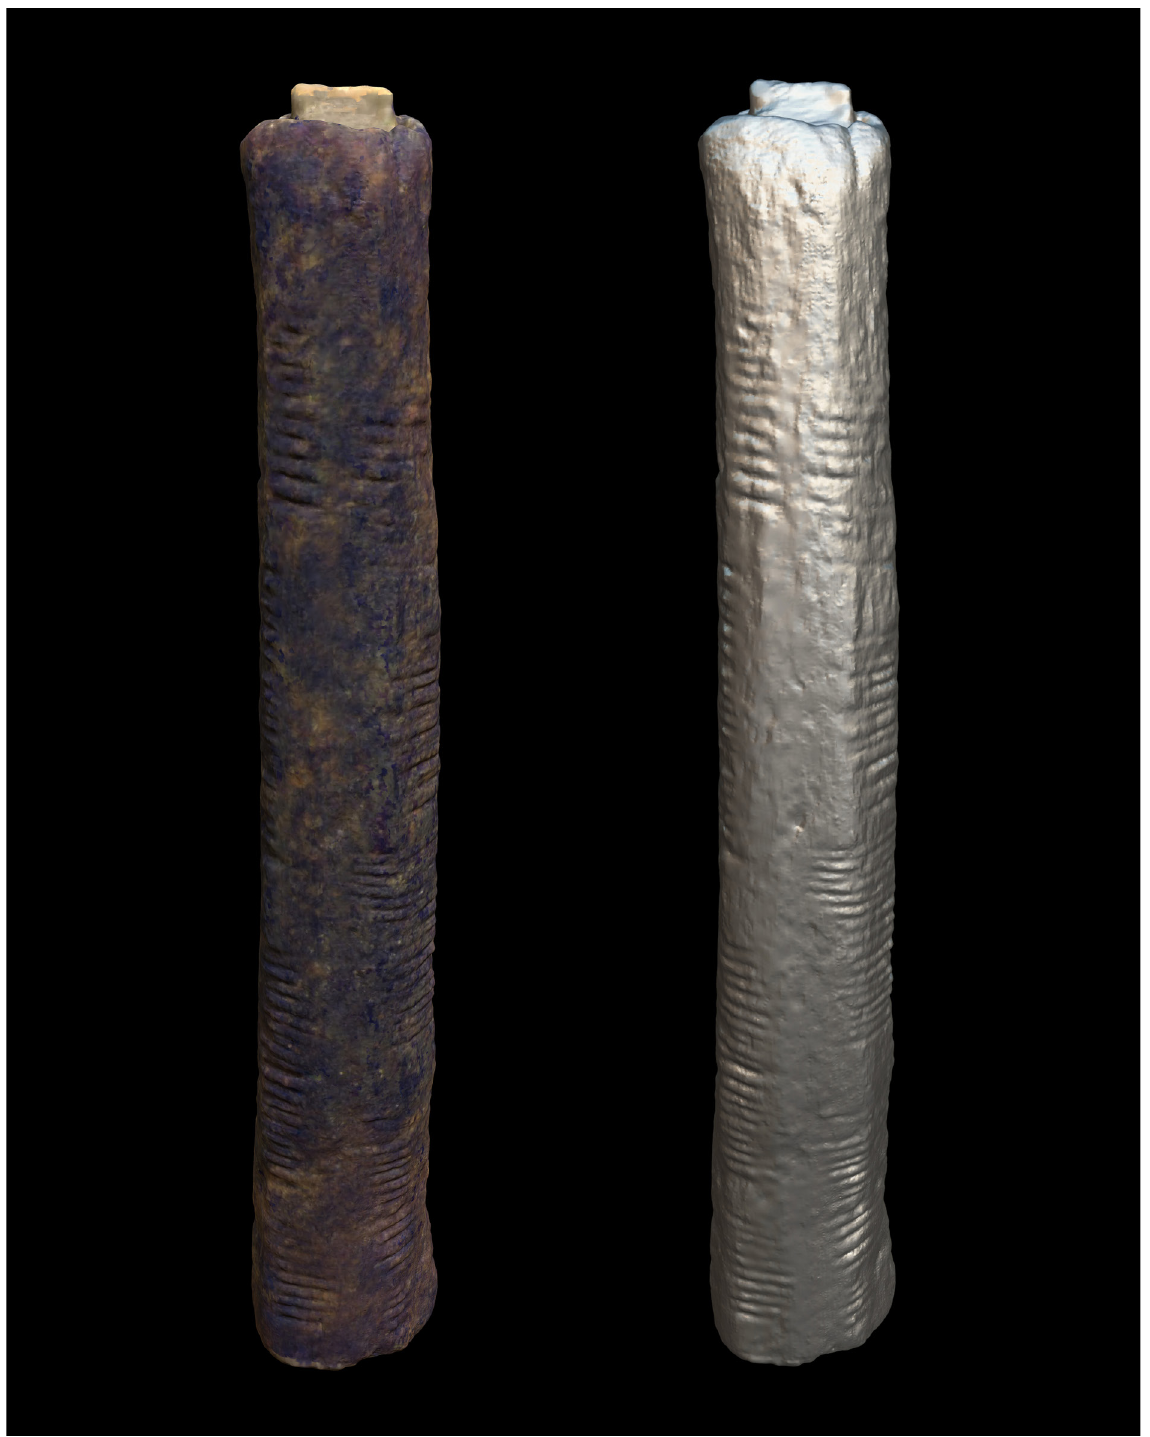
Fig. 3.32. Ishango rod digitised with NextEngine.